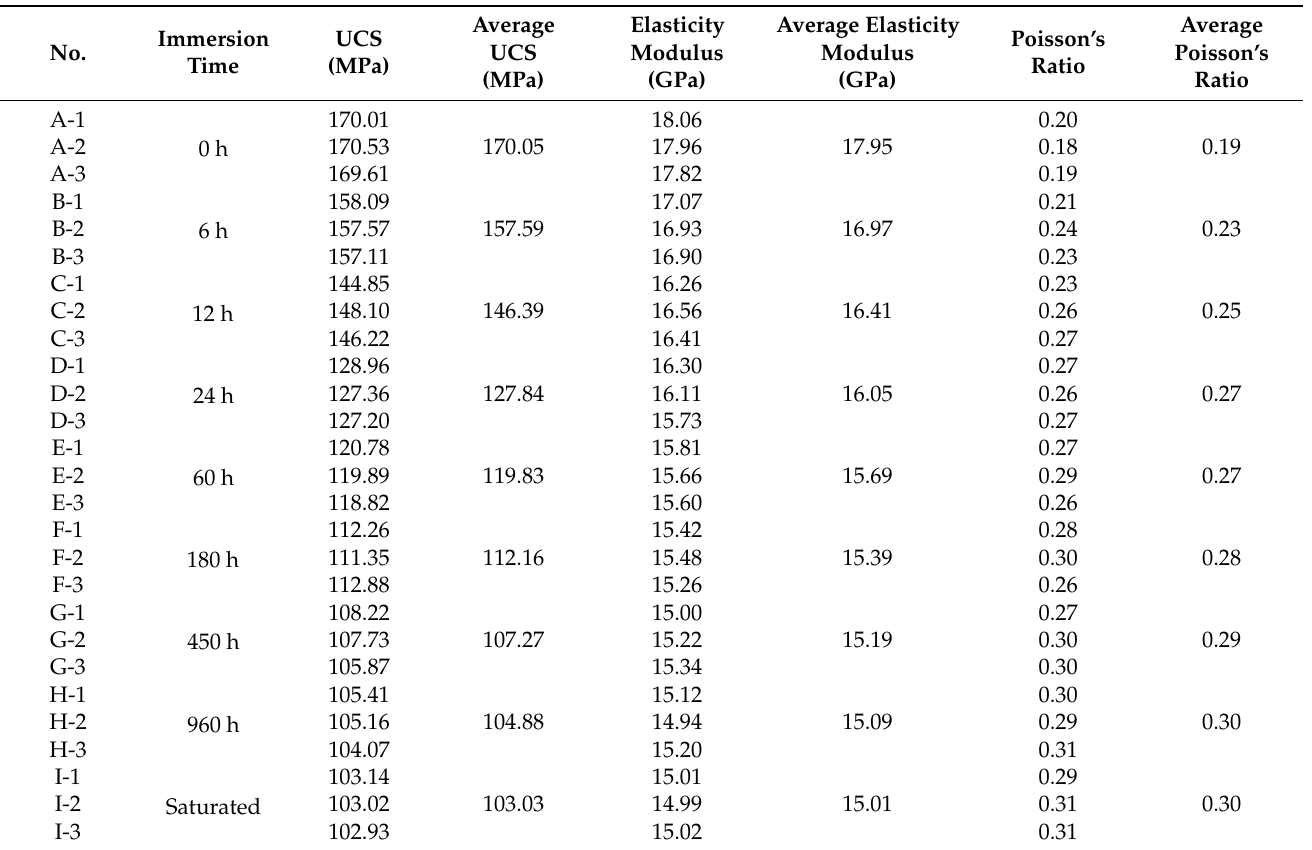
Table 3. Results of uniaxial compression